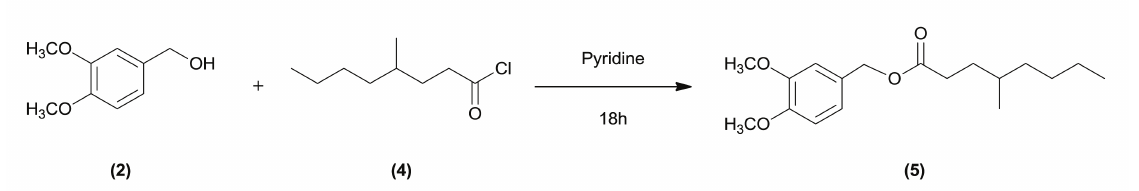
Figure 3: Step 3 of the synthesis procedure of (±)-DMBO. Procedure for the preparation of (±)-DMBO ( 5 ) from the acylation of 3,4- dimethoxybenzyl alcohol ( 2 ) with (±)-4-methyloctanoyl chloride ( 4